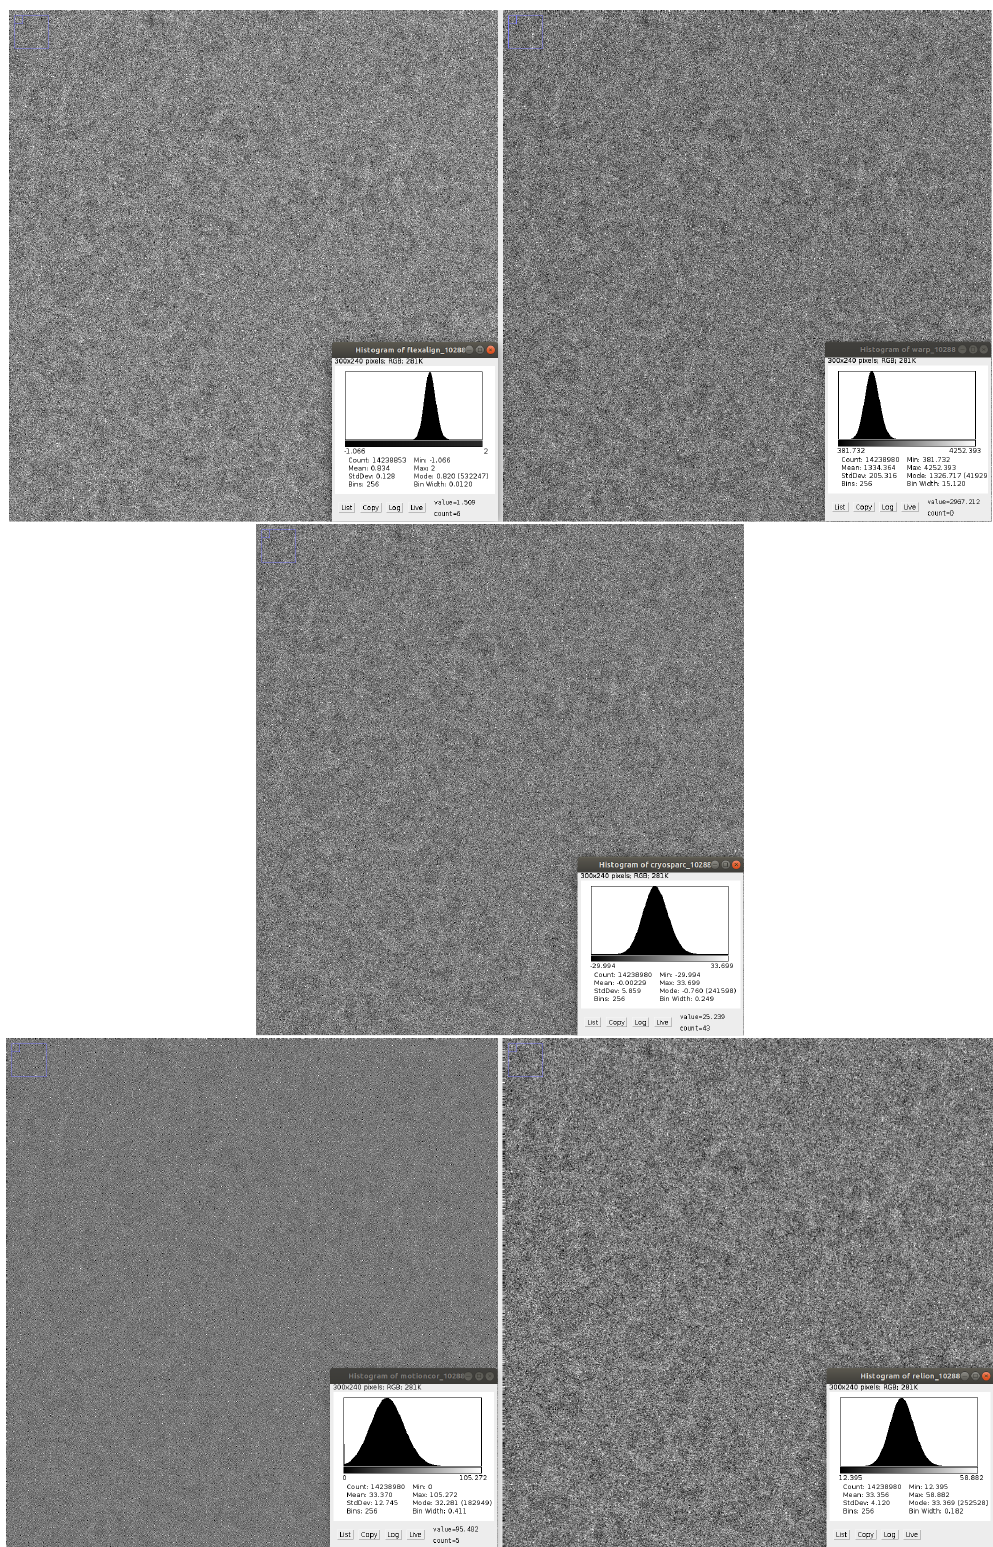
Figure 9. Detail of the produced micrograph using EMPIAR 10288 dataset (normalized) with histogram (before normalization): FlexAlign ( top left ), Warp ( top right ), cryoSPARC ( center ), MotionCor2 ( bottom left ), Relion MotionCor ( bottom right